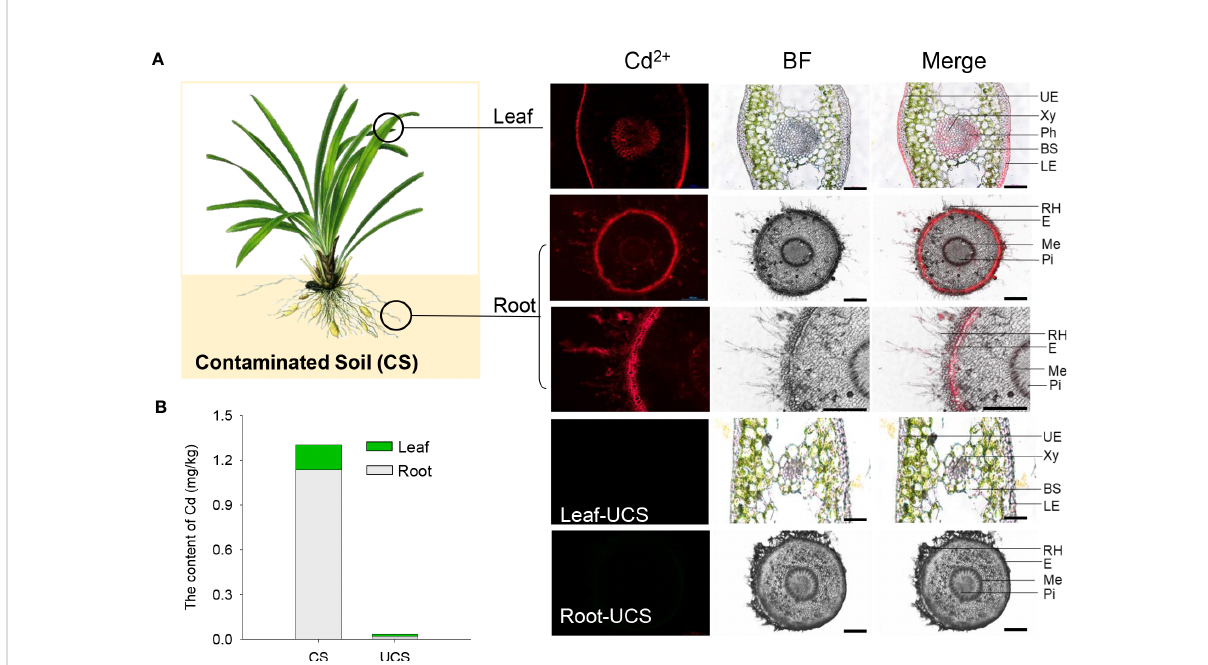
FIGURE 1 Analyses of Cd accumulation and distribution in Zhe-Maidong. (A) The distribution of Cd 2+ in Zhe-Maidong leaves and roots using Leadmium Green AM dye. BF, bright fi eld; Merge, the overlap of Cd 2+ fl uorescence and bright fi eld. For each treatment, images from three technical replicates for three biological repeats were collected. UE, upper epidermis; Xy, xylem; Ph, phloem; BS, bundle sheath; LE, lower epidermis; RH, root hair; E, epiblema; Me, metaxylem; Pi, pith. Bars = 100 µm. (B) The Cd content in different tissues of Zhe-Maidong. CS, contaminated soil; UCS, uncontaminated